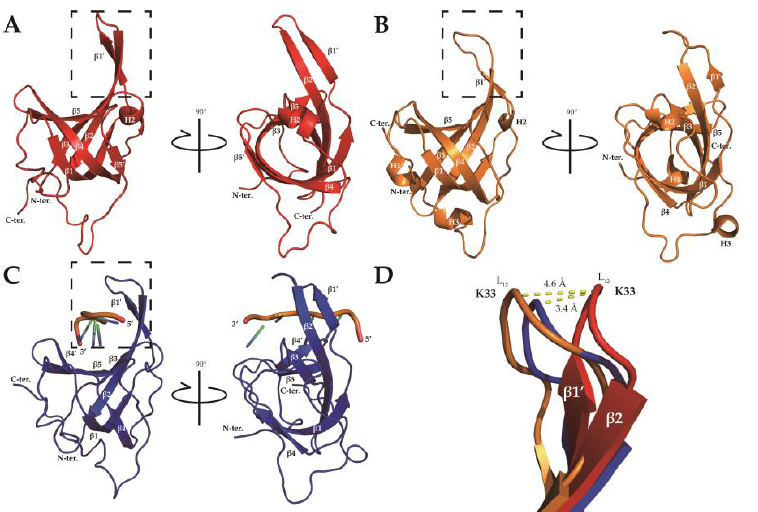
Figure 4. SsoSSB structures by ( A ) NMR at high temperature (PDB ID: 7WCG; indicated with red), ( B ) X-ray crystallography (PDB ID: 1O7I [14]; indicated with orange), and ( C ) NMR at room temperature in complex with ssDNA (PDB ID: 2MNA [15]; indicated with blue). ( D ) Magnified view of the L 12 loop in each of the 3 structures. The zoomed area is indicated by a dotted square in each figure ( A – C